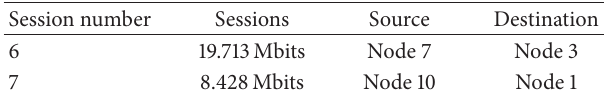
Table 6: Besides the five sessions listed in Table 5, two more sessions are added in this experiment.